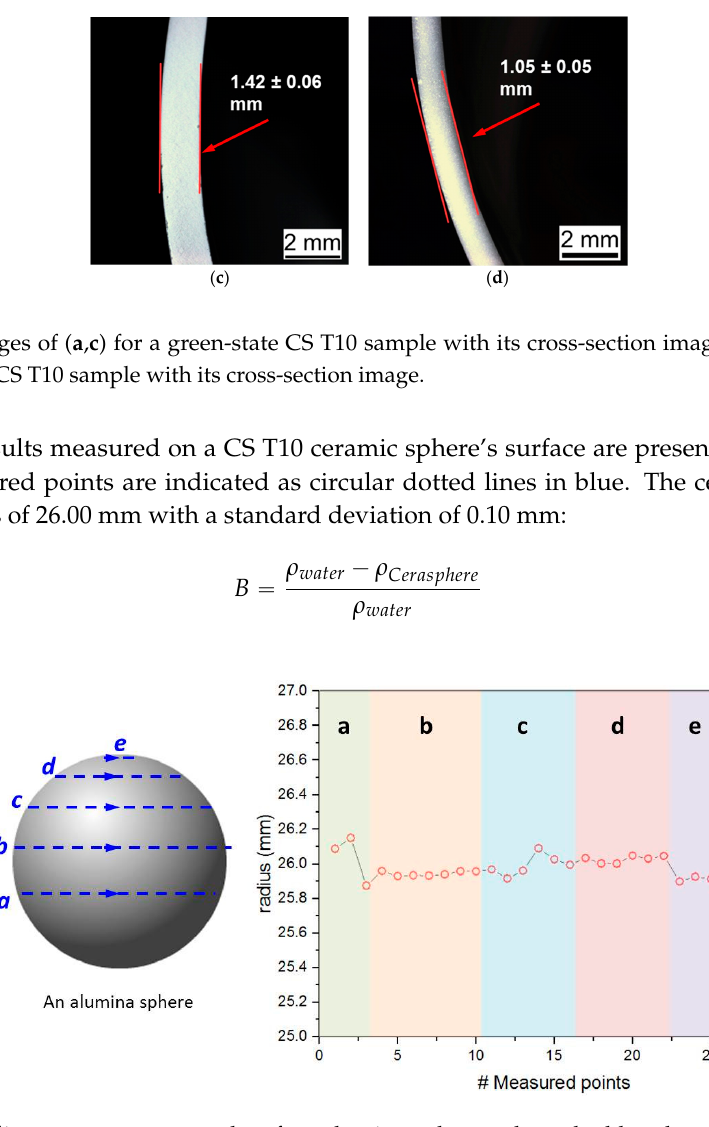
Figure 5. Radius measurement results of an alumina sphere, where the blue dotted lines are the measured areas in the sample.